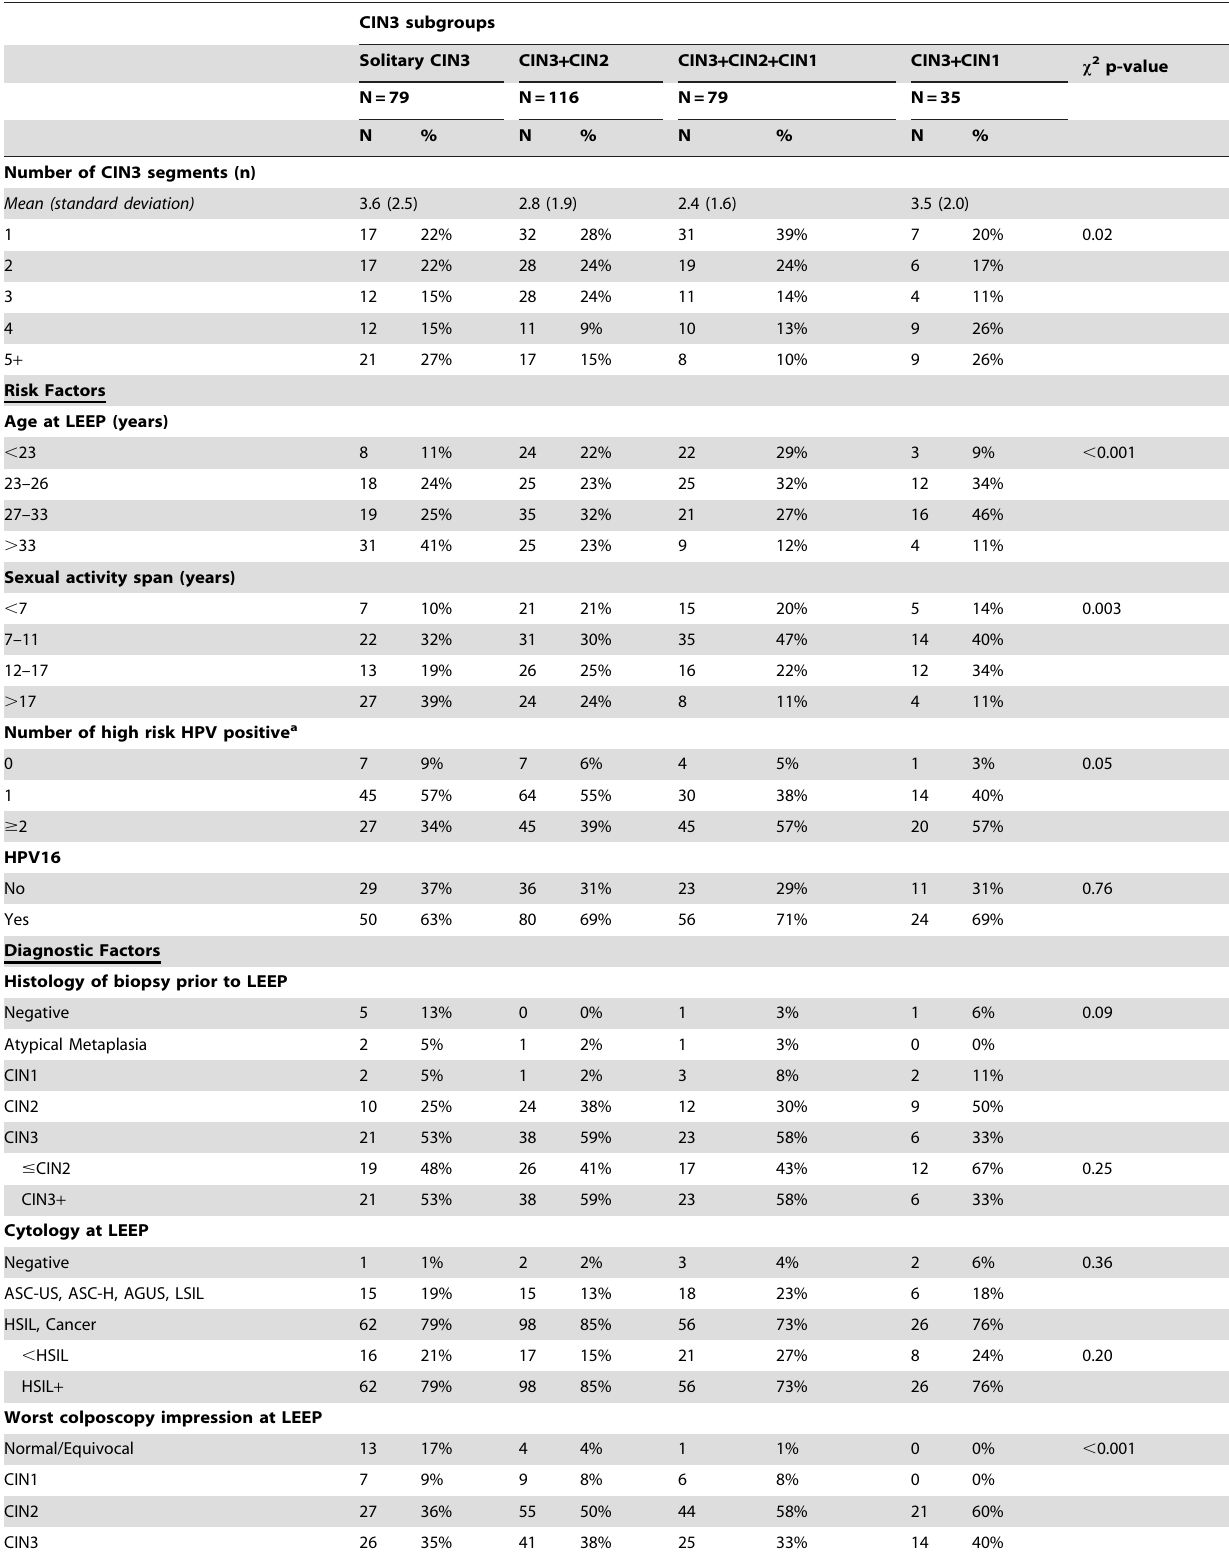
Table 2. Distribution of diagnostic factors among women in SUCCEED diagnosed as CIN3 by LEEP (N